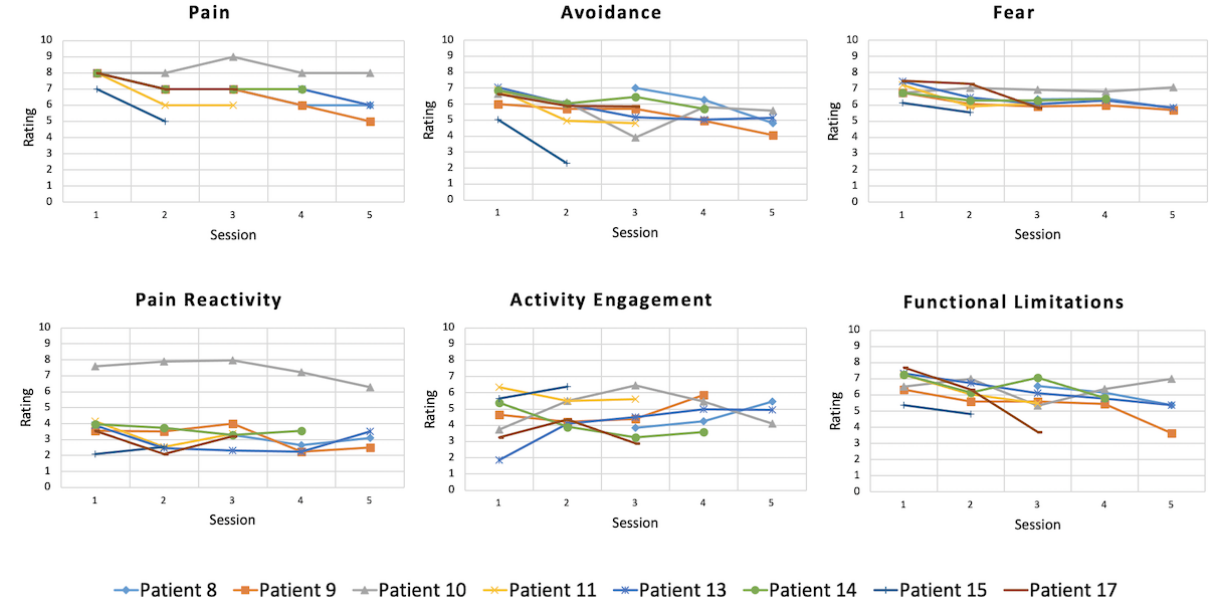
Figure 5. Multisession ratings of pain, fear, avoidance, activity engagement, and pain reactivity. Each line represents a patient’s multisession post-VR Child Daily Questionnaire ratings. As can be observed from the graphs, number of sessions/ratings ranged from 2 to 5. Repeated measures mixed model analyses revealed significant effects for time with decreases in pain, fear, avoidance, and functional limitations. No effects for time were observed for activity engagement or pain reactivity. VR: virtual